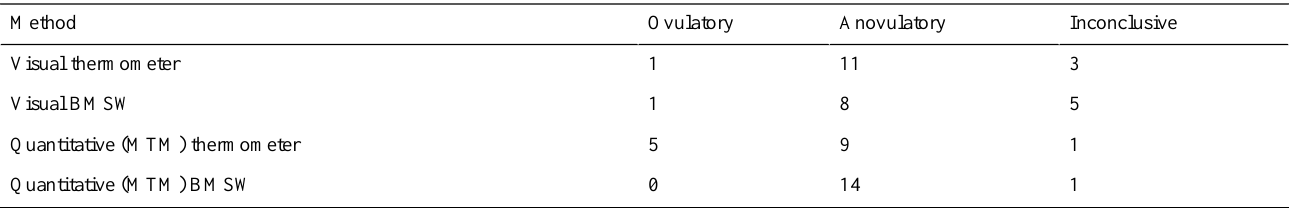
Table 2. Number of ovulatory, anovulatory, and inconclusive menstrual cycles detected by BMSW and the thermometer under visual a and quantitative b